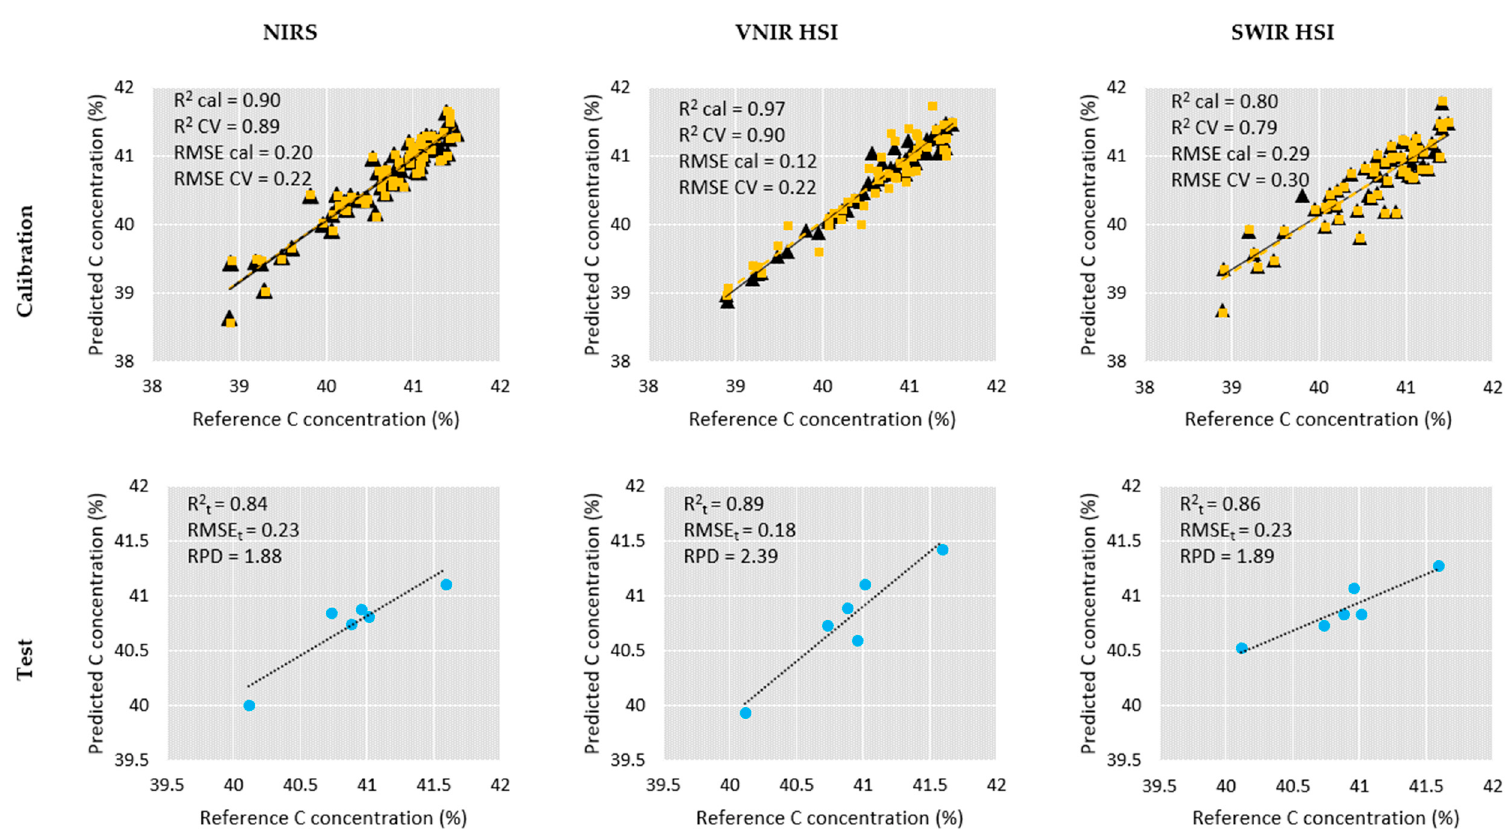
Figure 4. Carbon concentration (%) in feed samples analysed using the near infrared spectroscopy (NIRS, 400–2500 nm), visible to near infrared hyperspectral imaging (VNIR HSI, 400–1000 nm) and short-wave infrared HSI (SWIR HSI, 1000–2500 nm) in the calibration set and in the test set. Predictions in the calibration (cal) and cross-validation (CV) sets are presented in close triangles (solid lines) and squares (dashed lines), respectively. Predictions in the test set ( t ) are presented in close circles (dotted line).